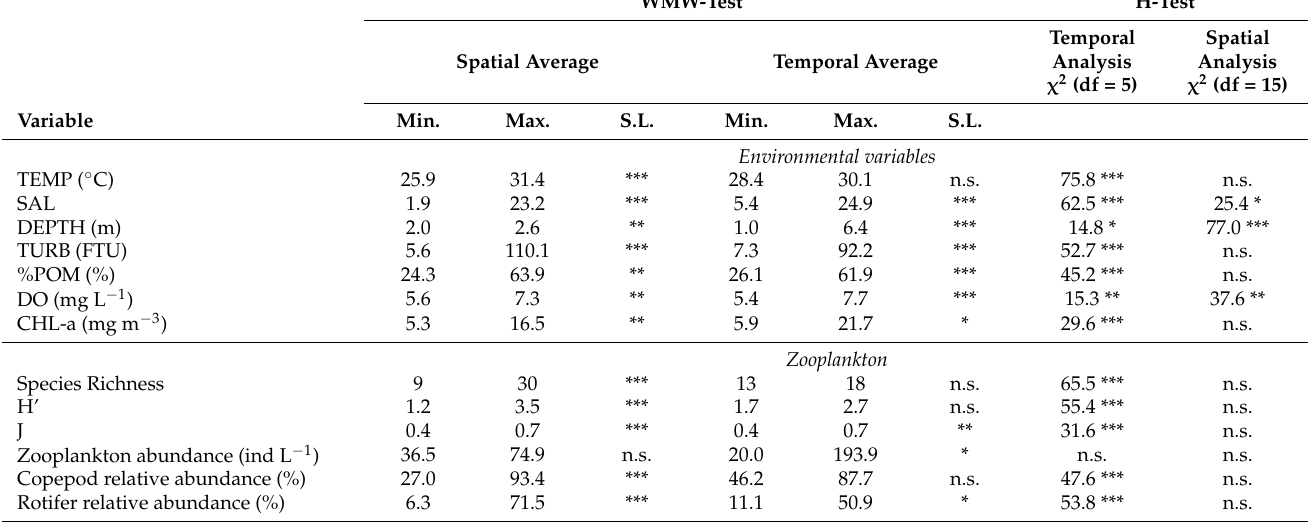
Table 2. Results of statistical analyses on environmental and zooplankton variables. Wilcoxon–Mann–Whitney test (WMW-test) was used to test the variations between the minimum (Min.) and maximum (Max.) mean values observed between two campaigns (spatial average) or between two stations (temporal average). Kruskal–Wallis test (H-test) was applied to test the significance of overall variations observed between the six campaigns (temporal analysis, df = 5) or between the 16 stations (spatial analysis, df = 15). Significance levels (S.L.): * p < 0.05, ** p < 0.01, *** p < 0.001,